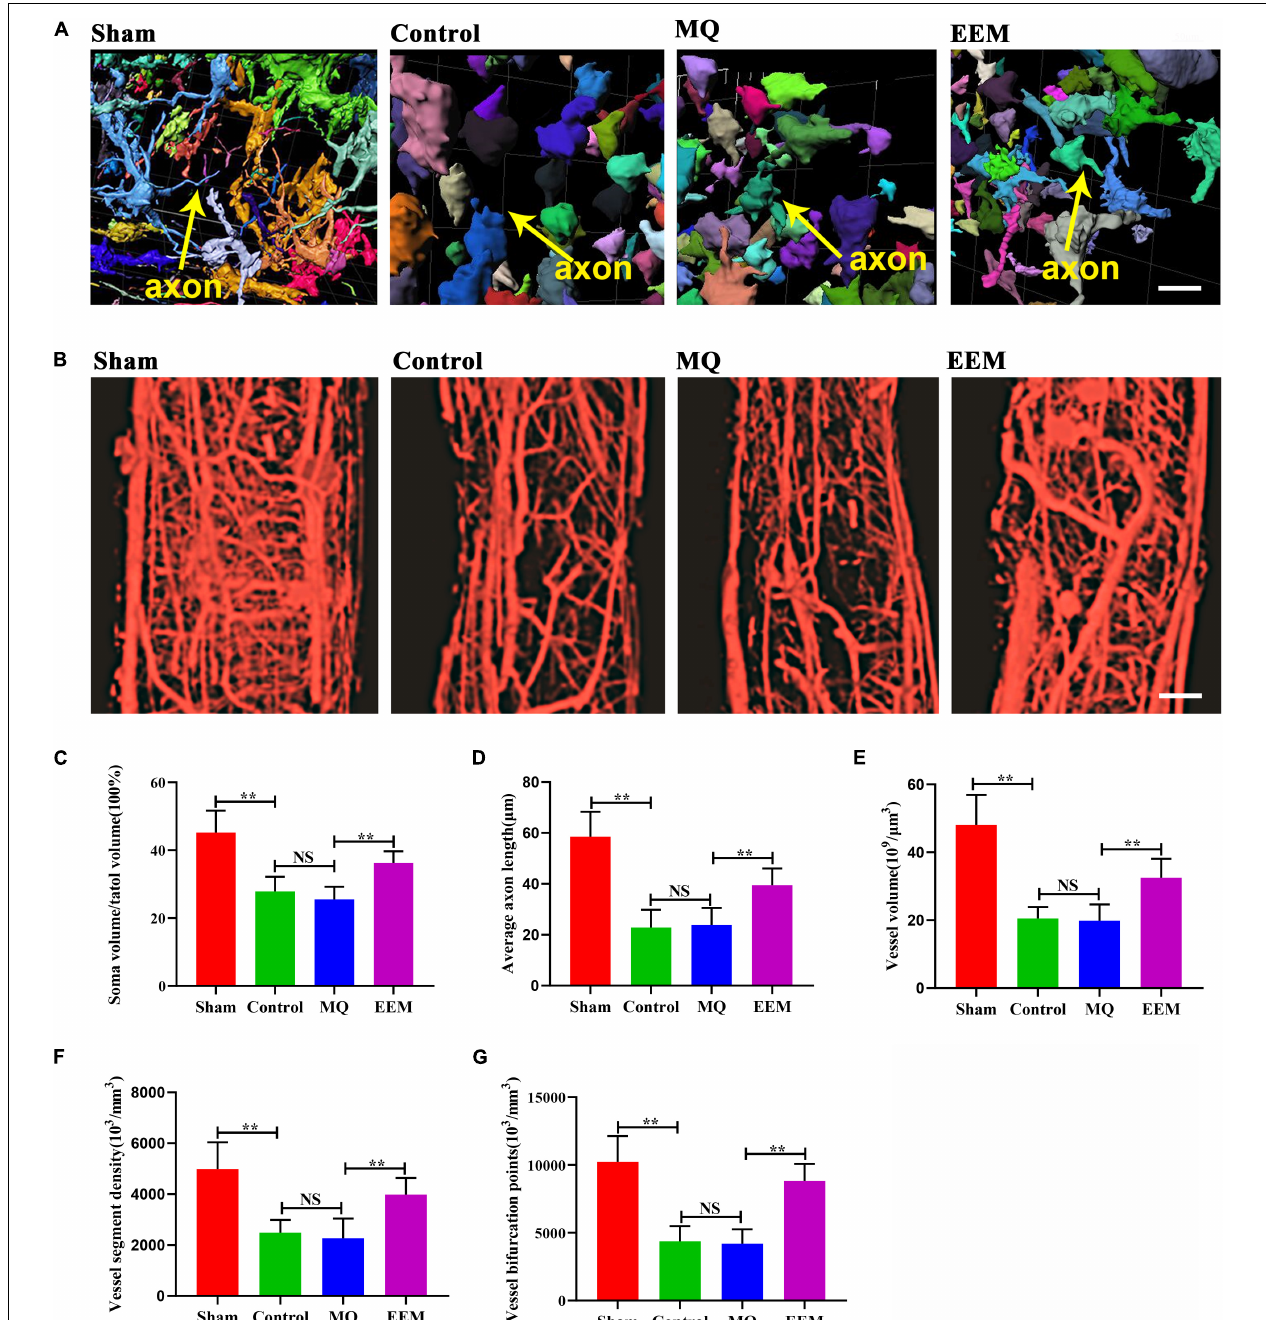
FIGURE 5 | EEM promote 3D morphological changes in spinal cord neurovascular network after SCI. (A) Representative 3D morphological image of spinal cord neuronal network changes including the presumptive fide axons among the different treatment groups. Scale bar: 10 µ m. (B) Representative 3D images of the spinal cord microvasculature in the different treatment groups. Scale bar: 100 µ m. (C) Percentage of soma volume to total volume in (A) [ F (3, 20) = 22.23, p < 0.01. Tukey’s post hoc test. Control vs. Sham, p < 0.01; MQ vs. Control, p = 0.82; MQ vs. EEM, p < 0.01; n = 6 animals for each group]. (D) Average axon length in (A) [ F (3, 20) = 28.74, p < 0.01. Tukey’s post hoc test. Control vs. Sham, p < 0.01; MQ vs. Control, p = 0.99; MQ vs. EEM, p < 0.01; n = 6 animals for each group]. (E) Quantification of vessel volume in (B) [ F (3, 20) = 29.02, p < 0.01. Tukey’s post hoc test. Control vs. Sham, p < 0.01; MQ vs. Control, p = 0.99; MQ vs. EEM, p < 0.01; n = 6 animals for each group]. (F) Quantification of vessel segment density in (B) [ F (3, 20) = 16.51, p < 0.01. Tukey’s post hoc test. Control vs. Sham, p < 0.01; MQ vs. Control, p = 0.95; MQ vs. EEM, p < 0.01; n = 6 animals for each group]. (G) Quantification of vessel bifurcation in (B) [ F (3, 20) = 30.05, p < 0.01. Tukey’s post hoc test. Control vs. Sham, p < 0.01; MQ vs. Control, p = 0.99; MQ vs. EEM, p < 0.01; n = 6 animals for each group]. The data are presented as the means ± SD. * p < 0.05, ** p < 0.01, NS = Not significant.